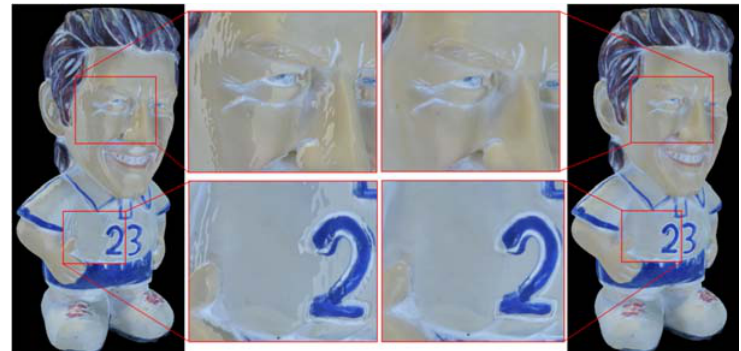
Figure 6. The Comparison Between Traditional and Seamless Texture Mapping